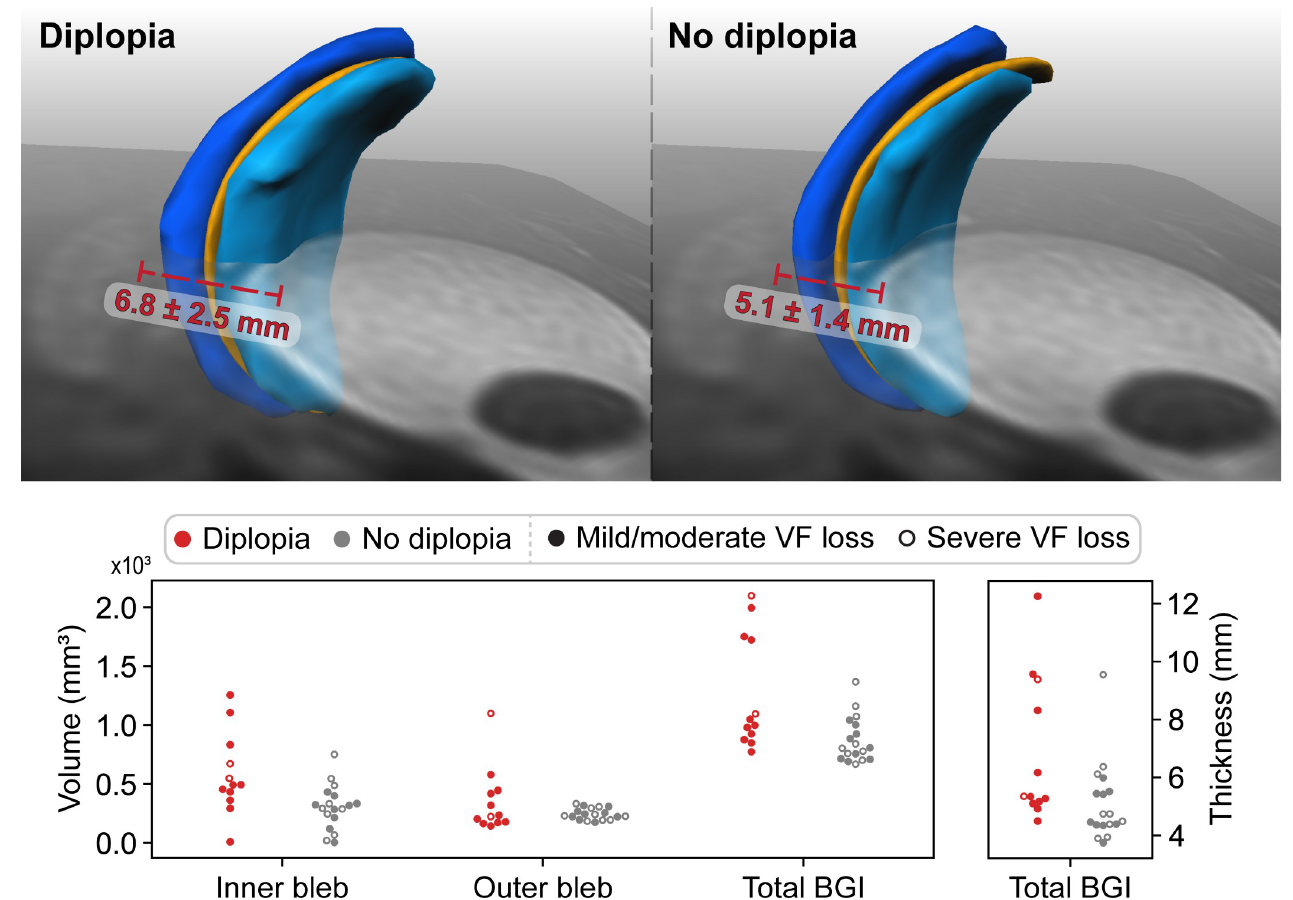
Fig 3. Comparison between the BGI of patients with and without diplopia. Top left) The average BGI complex volume for patients with diplopia, with the average largest thickness in red. Top right) The average BGI complex volume for patients without diplopia, with the average largest thickness in red. Bottom) Scatterplots of the individual BGI dimensions of patients (each dot represents a patient) with (red) and without (grey) diplopia. The filled or not open dots represent the visual field loss category of the patient with a filled dot being a patient with mild to moderate visual field (VF) loss (MD > -12dB), and an open dot being a patient with advanced visual field loss (MD <